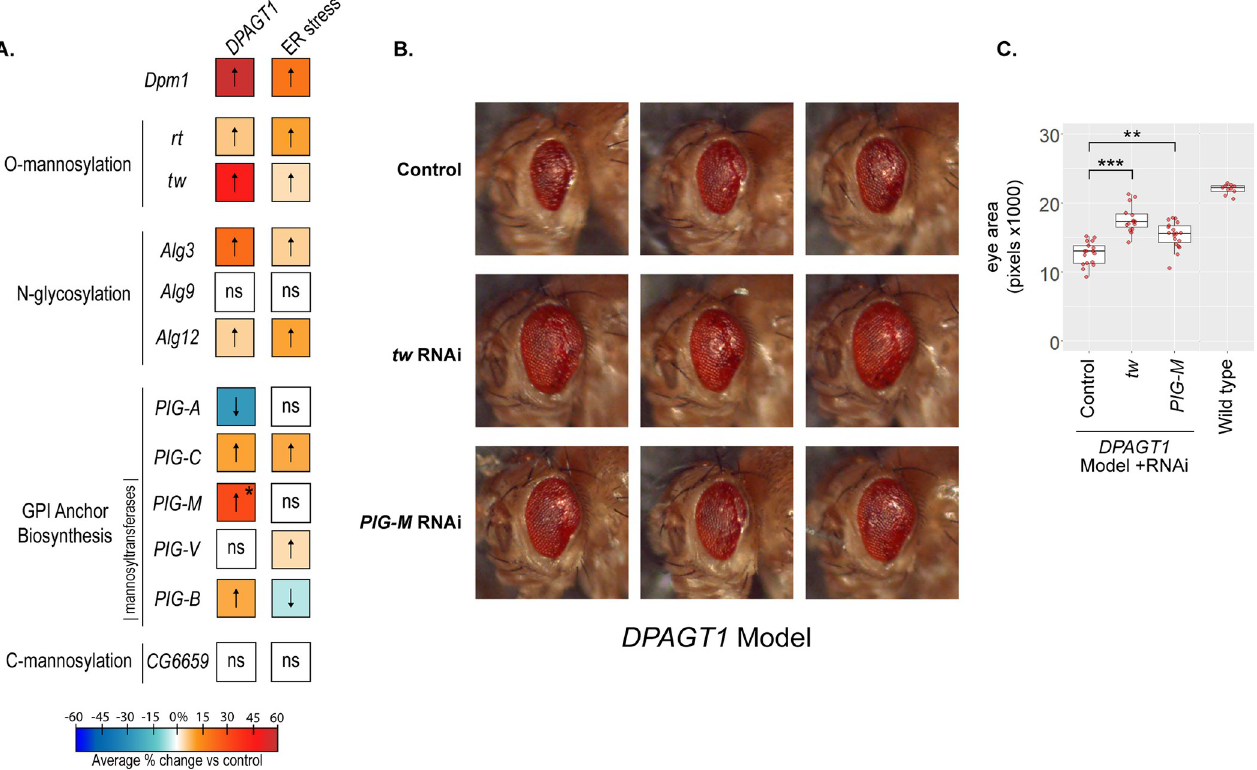
Fig 4. Knockdown of glycosylation pathways rescues the DPAGT1 and ER stress models. (A) A summary of RNAi data performed on downstream DPM1 glycosylation pathways. The majority of mannosyltransferases tested in O-mannosylation, N-glycosylation, and GPI anchor biosynthesis pathways increased eye size in the DPAGT1 model. Colors denote % change of eye size vs their control; warmer colors (or up-arrows) have a stronger effect, and vice versa. Colors are derived from the averages of at least 2 biological replicates with at least one significant replicate and no opposite results (see S7 Table for all RNAi data). � = One PIG-M RNAi line was very strong (BDSC 51890), while a second line was neutral/negative in response (see S7 Table). (B) Representative images of the DPAGT1 model crossed with RNAi against the two strongest hits, tw and PIG-M . Shown are three representative images from the same RNAi line and experimental cross ( tw : BDSC 55735, PIG-M : BDSC 51890) or control RNAi background (attP40: BDSC 36304). (C) Quantification of tw and PIG-M rescue shown in B. For reference, the total quantification of that experiment, as well as a representative wild type DPAGT1 genetically-matched background strain crossed to the control RNAi line, is included. �� p < 0.01, ��� p < 0.001 (Student’s t test). https://doi.org/10.1371/journal.pgen.1010430.g004 PLOS Genetics | https://doi.org/10.1371/journal.pgen.1010430 September 27,